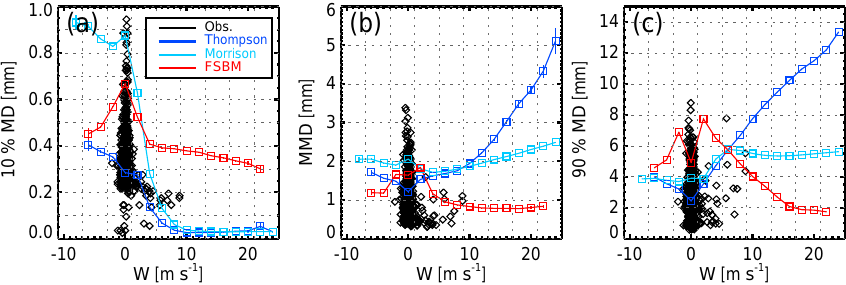
Figure 10. As in Fig. 11, but for temperatures between − 8 and − 16 ◦ C. Observations are plotted as black diamonds displaying individual data points due to lower sample sizes in this temperature